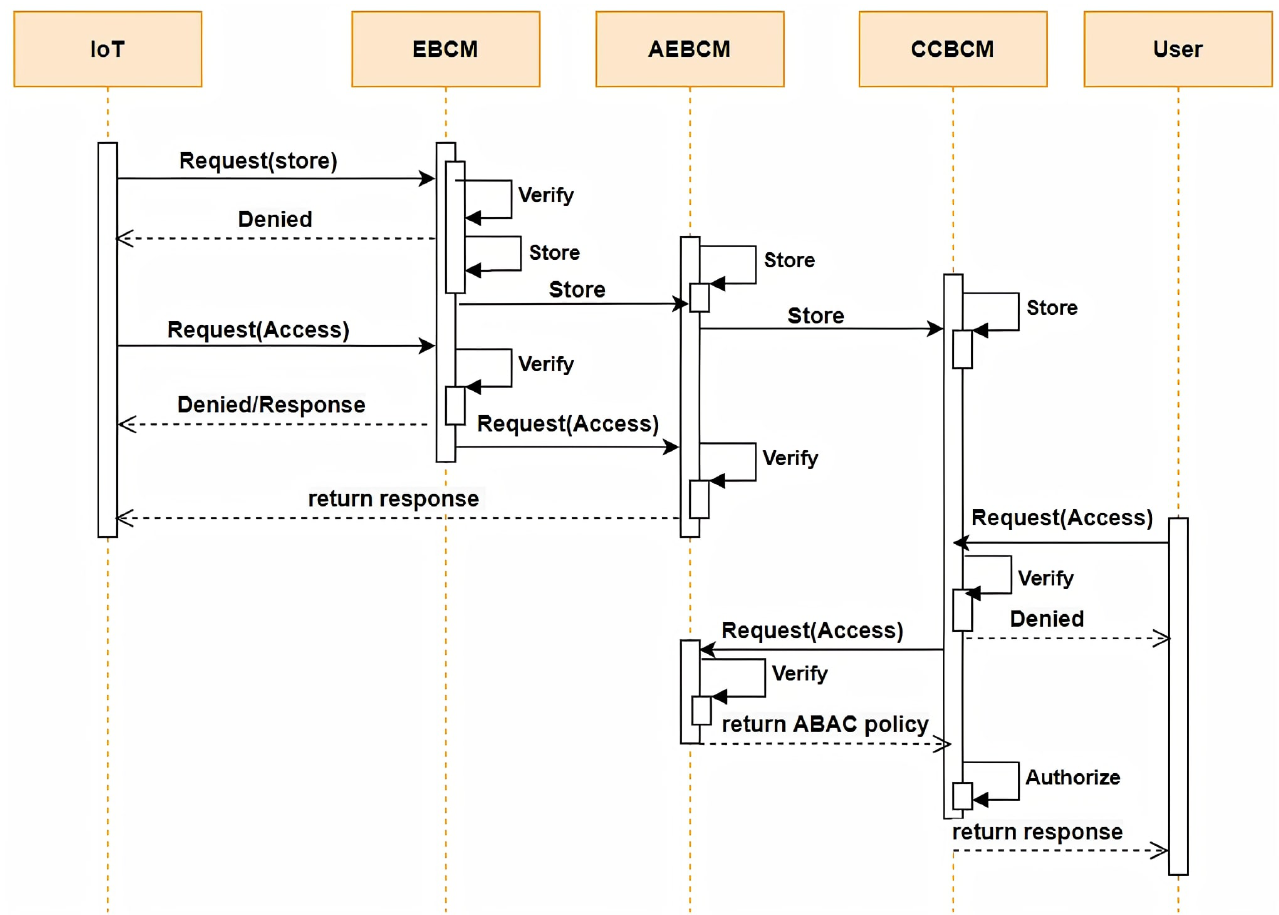
Figure 3. Sequence diagram of the proposed